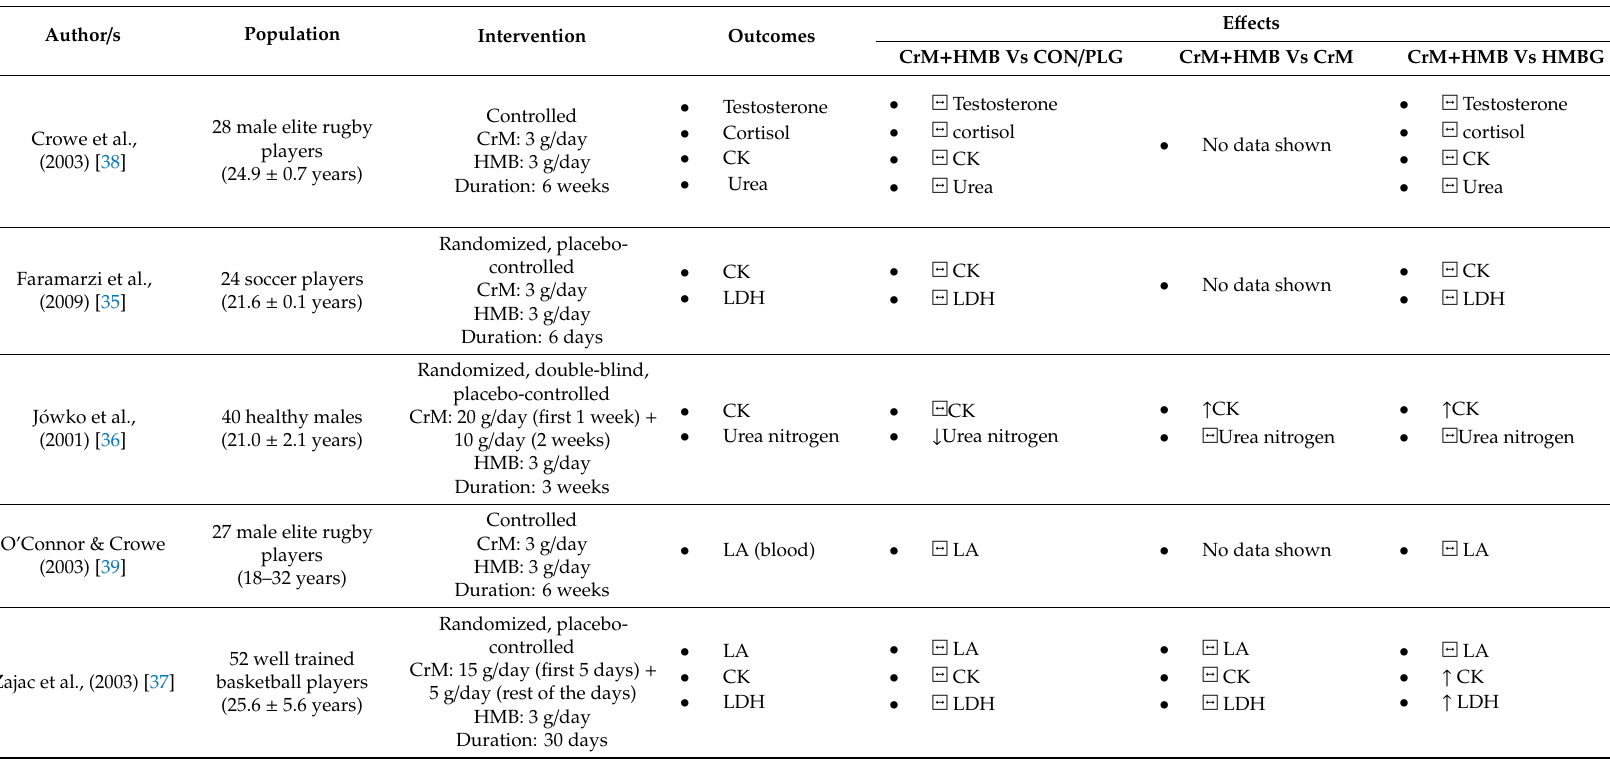
Table 3. Summary of studies included in the systematic review that investigated the e ff ect of CrM plus HMB on markers of muscle damage and hormone status